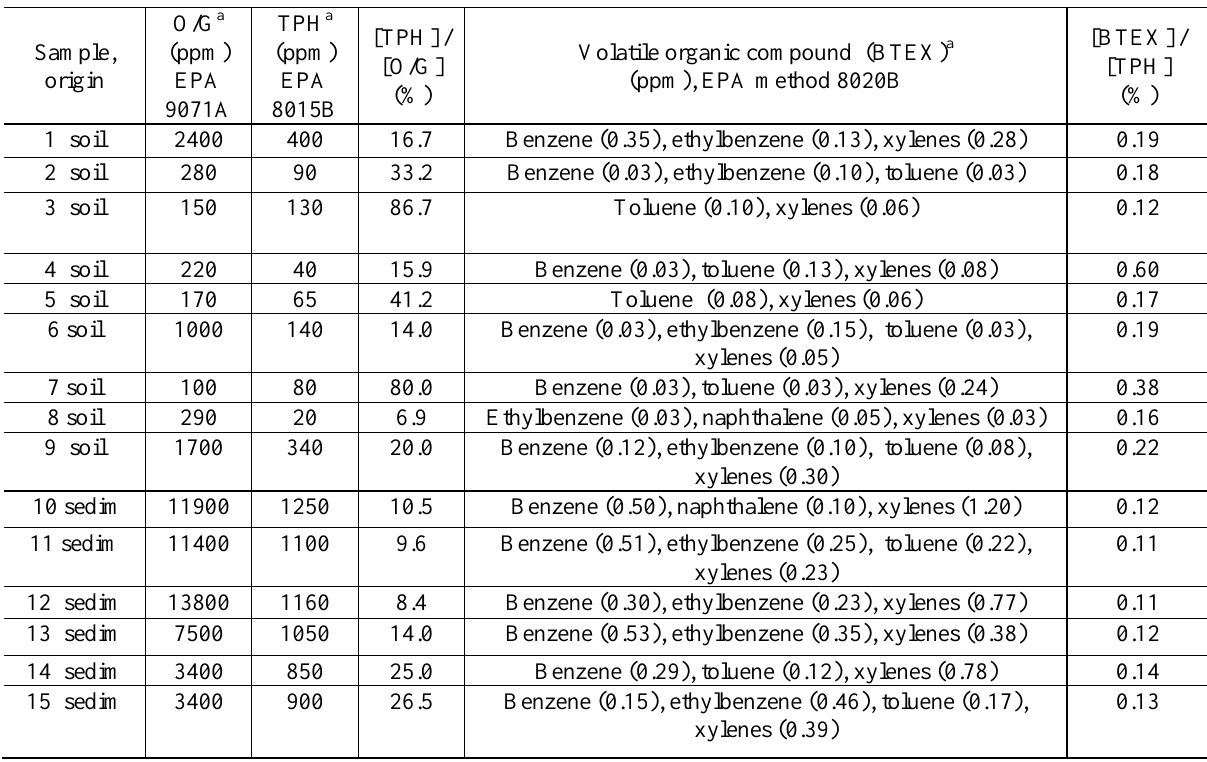
Table 1. Oil/grease (O/G), total petroleum hydrocarbons (TPH) and volatile aromatic compounds (BTEX) in soil/sediment samples